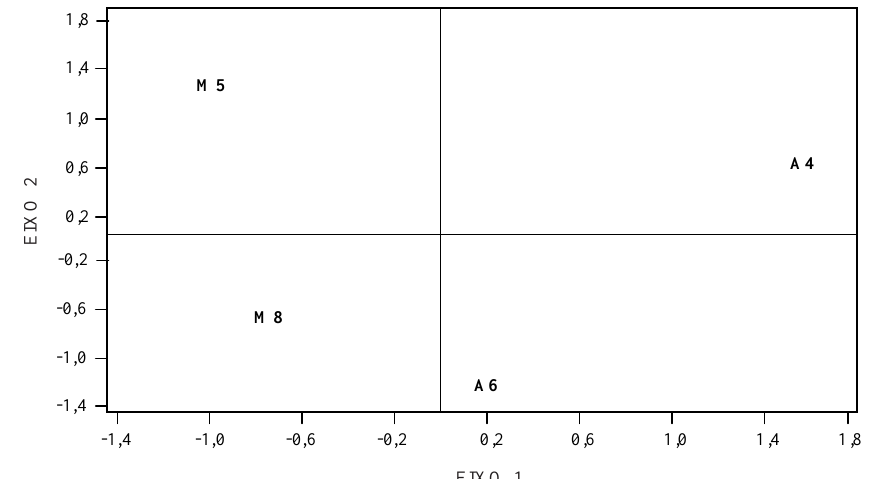
Figura 6. Produtividade para as culturas - Produtividade de arroz 94 (A4) / Produtividade de milho 95 (M5) / Produtividade de algodão 96 (A6) / Produtividade de milho 98 (M8).